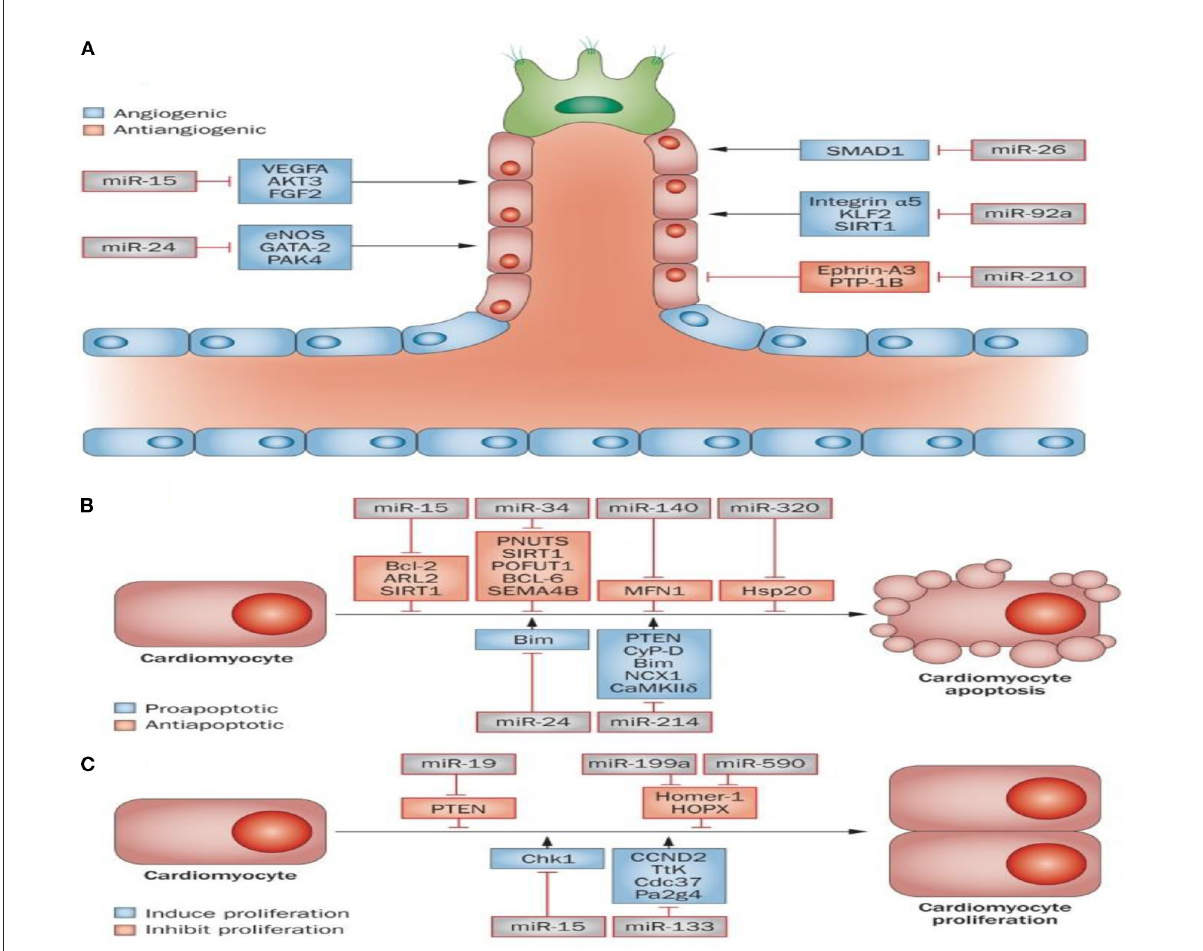
FIGURE1 Role of microRNAs in MI. Some miRNAs are known to be implicated in cardiac muscle angiogenesis (A) , cardiac cell survival, and proliferation (B,C) . Angiogenesis is pivotal for the delivery of oxygen and essential nutrients to heart muscle. Angiogenesis can be activated or repressed by a number of microRNAs. For instance, miR-15, miR-24, miR-26, and miR-92a all repress angiogenesis through inhibition of endothelial-cell functions. In contrast, miR-210 prompts angiogenesis via inhibiting several antiangiogenic factors (A) . A number of miRNAs have been identified to be involved in the apoptosis and survival of cardiac cells. Apoptosis inhibition or an increase in survival signals promotes cardiac regeneration. The miR-15 family (miR-320, miR-34, and miR-140) can serve as pro-apoptotic factors, while miR-24 and miR-214 can act as anti-apoptotic factors (B). The proliferation of cardiac cells is limited; however, cardiac regeneration can increase following stimulation of proliferation. It has been shown that miR-19, miR-199a and miR-590, can promote proliferation of cardiac cells, while both miR-15 and miR-133 inhibit cardiac cell proliferation (C) . This figure adapted from Boon and Dimmeler